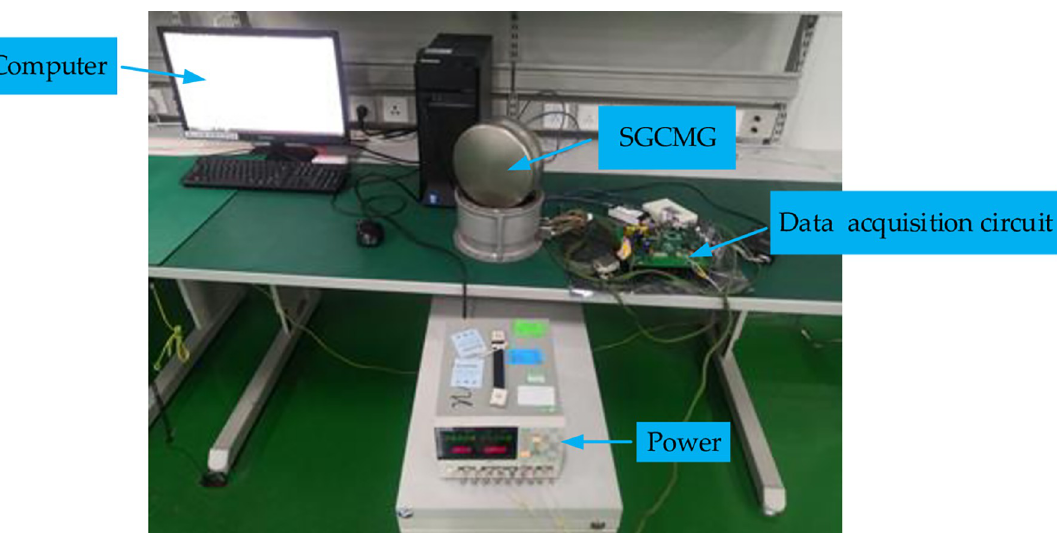
Fig 9. System identification